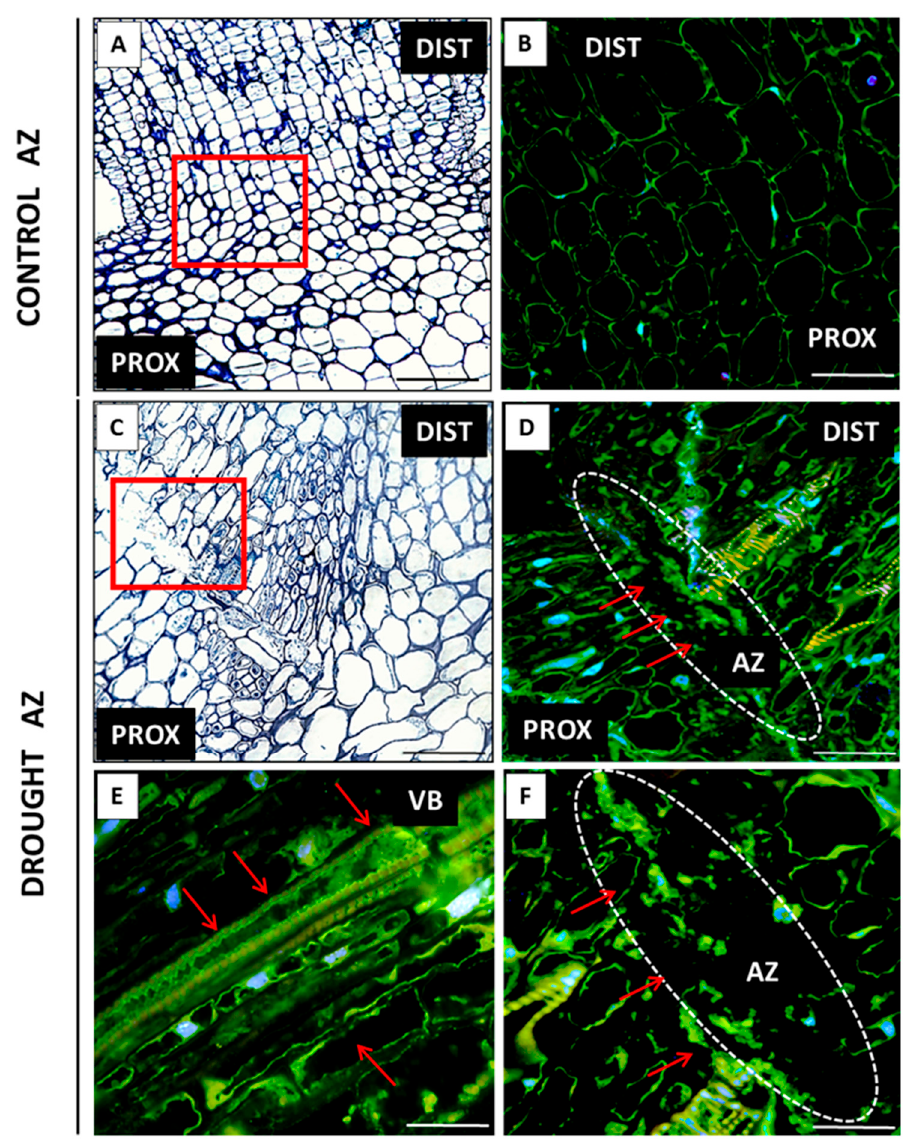
Figure 7. Tissue and subcellular localization of abscisic acid (ABA) in the abscission zone (AZ) of Lupinus luteus flowers grown in drought conditions ( D – F ) and in the AZ of control plants ( B ). The AZs were excised on the 48th day of development. Control plants were cultivated under optimal soil conditions (70% WHC). Part of plants was subjected to drought conditions for 2 weeks (25% WHC). The AZ regions are indicated by white curves ( D , F ). The presence of ABA ( D – F ) is highlighted by red arrows. Image F is magnified D region. Image E corresponds to the vascular bundles’ area. DAPI was used for nuclei staining. The examined regions of AZs used for the immunofluorescence studies are indicated by red squares ( A , C ). Abbreviations: PROX—stem fragments below the AZ, DIST—flower pedicel fragments above the AZ, VB—vascular bundles. Scale bars: 100 µm ( A , C , D ), 60 µm ( B ), 40 µm ( E , F ).